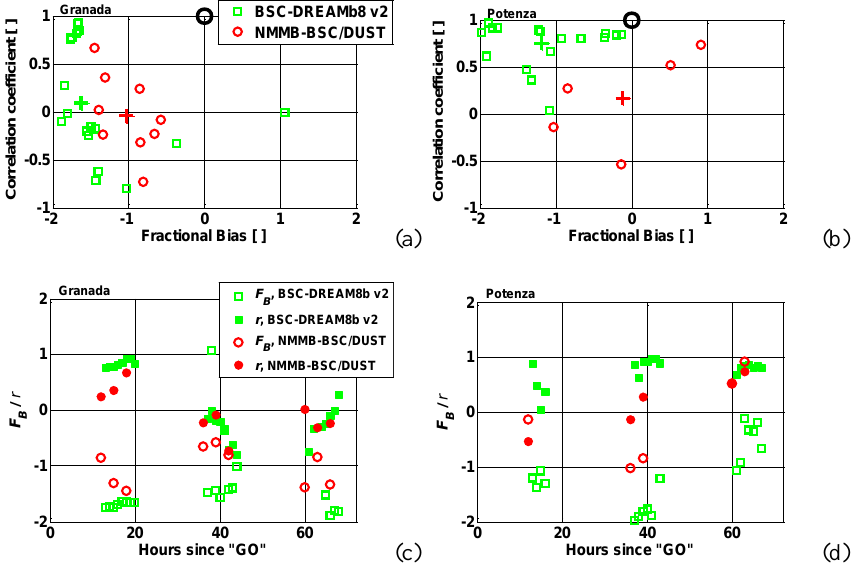
Figure 13. Correlation coefficient vs. fractional bias (a) in Granada and (b) in Potenza. The crosses indicate the mean values and the black circle indicates the ideal pair ( r , F B ) = ( 1 , 0 ) . Correlation coefficient and fractional bias vs. time (c) in Granada and (d) in